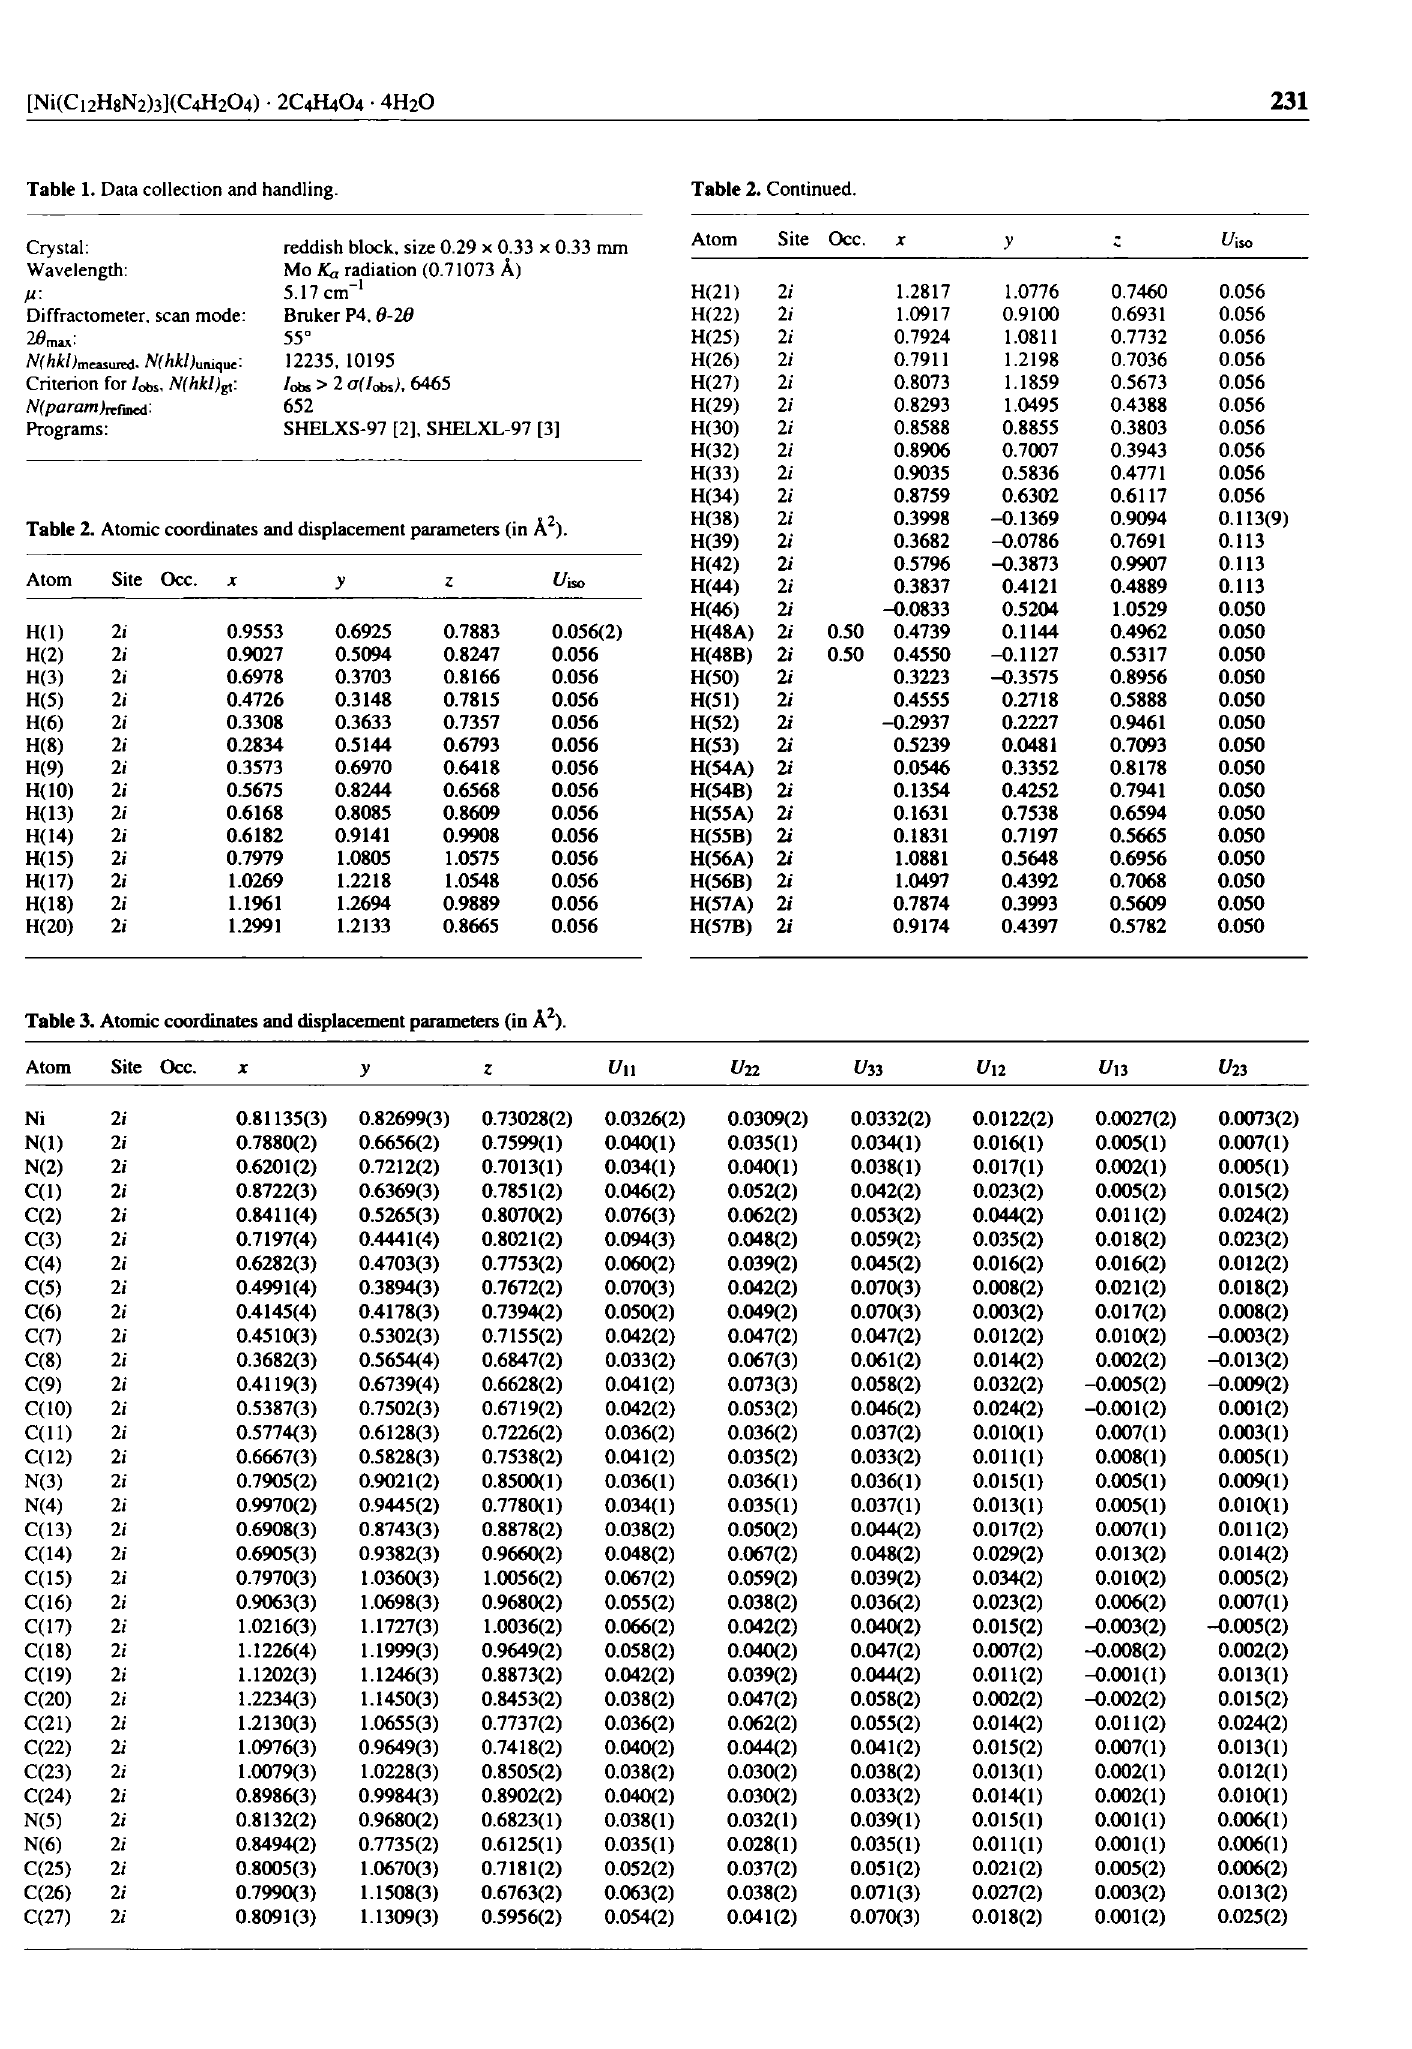
Table 2. Atomic coordinates and displacement parameters (in Â 2 ).